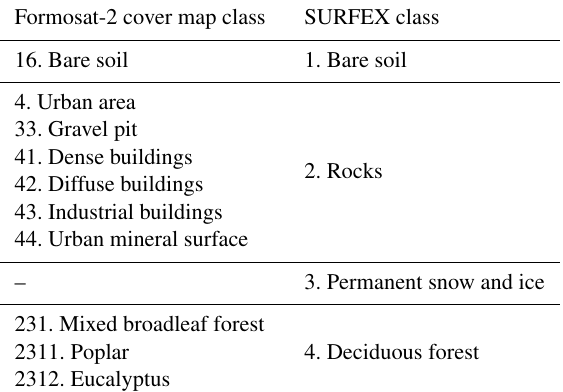
Table 1. Aggregation rules of Formosat-2 cover maps by SURFEX vegetation